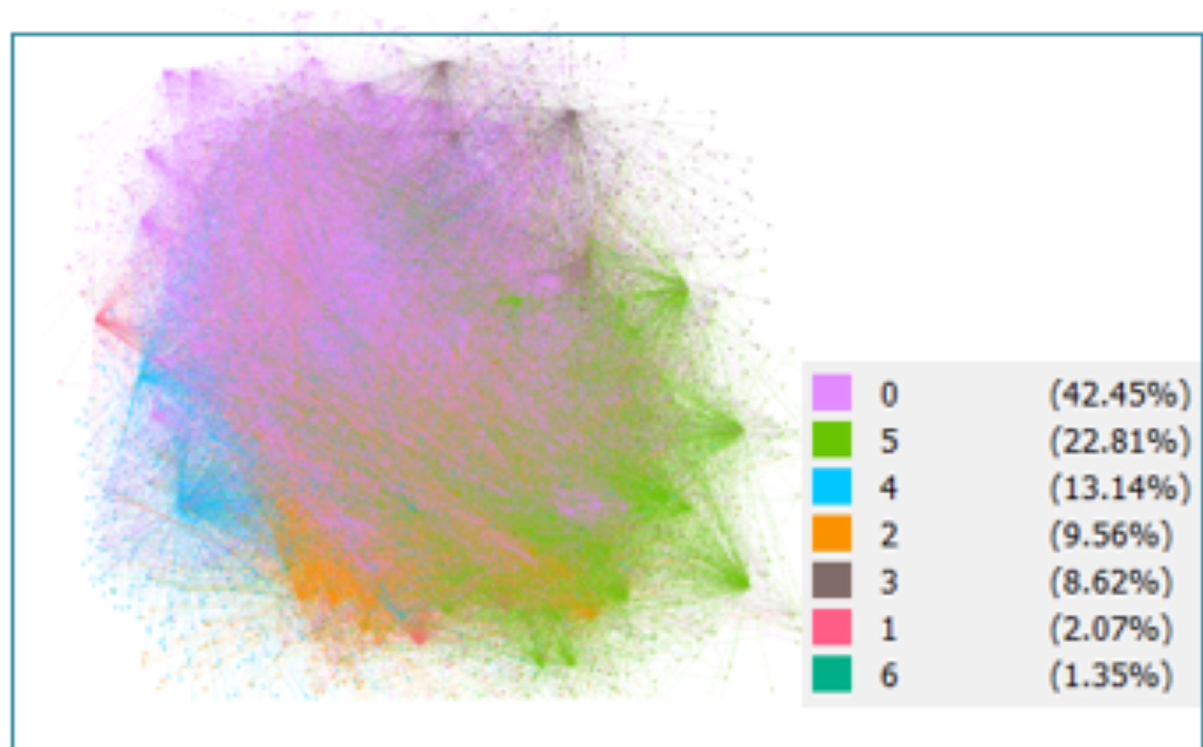
Fig. 2 Modules of the 2018 multidisciplinary psychology citation network. Dots are nodes representing a journal. Lines are connectionsbetween nodes indicating that an article in one journal cited an article in another journal. The different colors indicate the set of nodes thatbelong to a common module.